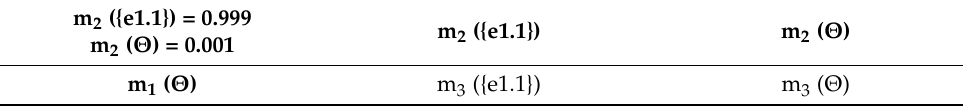
Table 3. Observation e1.1.